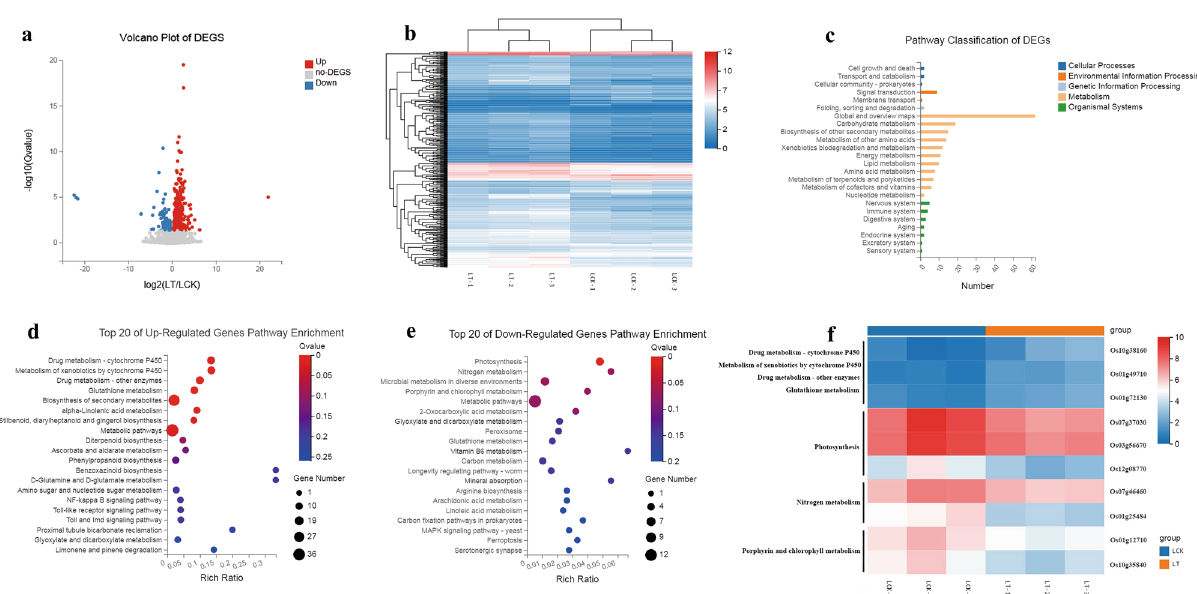
Figure 5. Actual growth of weeds in Chrysanthemum morifolium field with A. argyi treatment.